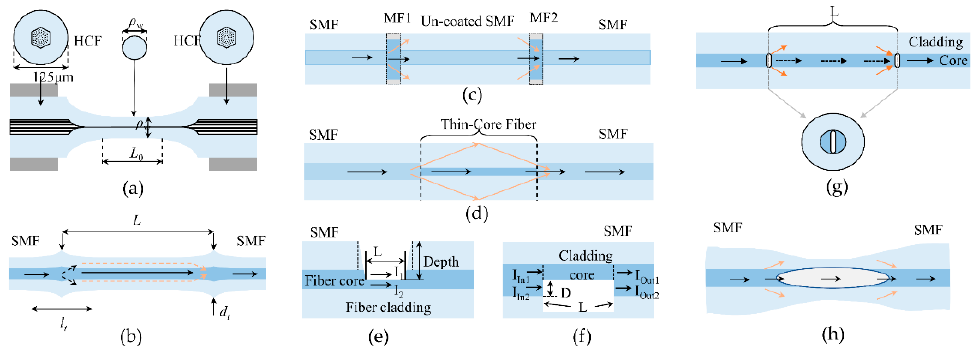
Figure 5. Typical types of MZI sensors for high-temperature measurements realized with optical fiber tapers ( a , b ), core diameter mismatch ( c , d ), trench structure ( e , f ), laser micromachining ( g , h ): ( a ) MZI consists of a holey fiber taper with collapsed air holes in the waist [69]; ( b ) MZI consists of two waist-enlarged fiber bitapers in a circular step-index SMF; ( c ) MZI by splicing MMF-SMF-MMF; ( d ) MZI by splicing SMF-TCF-SMF; ( e ) MZI consists of a side-ablated structure on the SMF; ( f ) MZI by removing part of the fiber core and cladding by fs laser micromachining; ( g ) MZI by concatenat- ing two microcavities separated by a middle section; ( h ) MZI by drawing SMF with hollow sphere into microfiber by use of flame brushing technique.